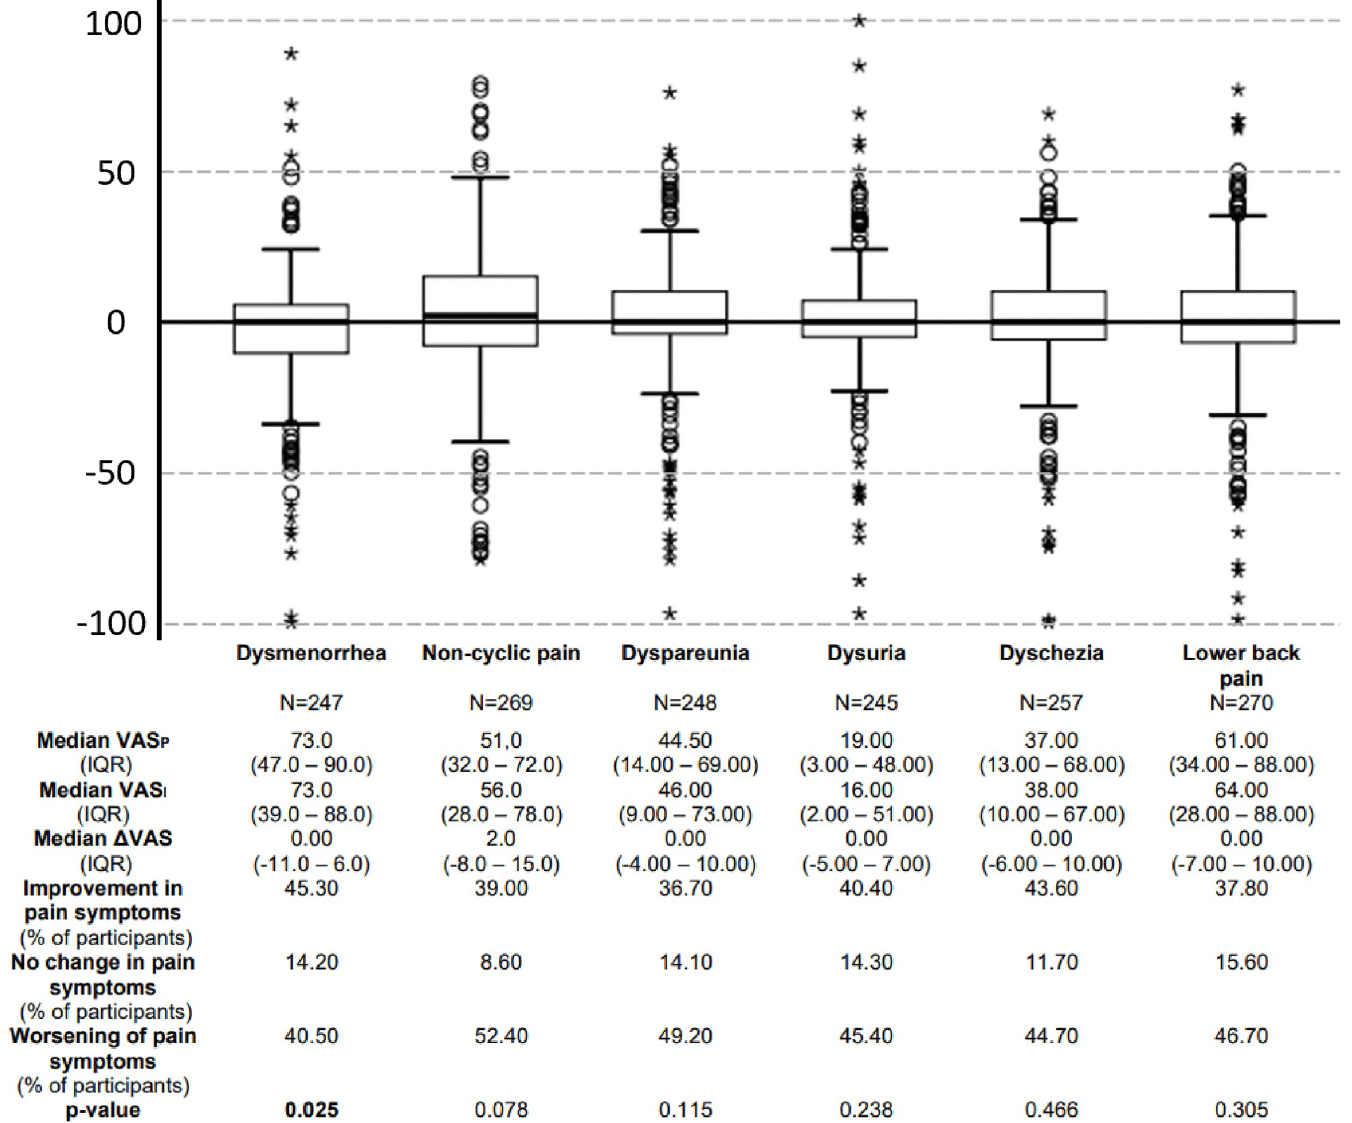
Fig 1. Differences of pain intensity ( Δ VAS) during social isolation or quarantine (VAS I ) and previous to social isolation or quarantine (VAS P ). Boxplots of the differences of pain intensity are displayed in all assessed pain modalities. Positive values mean increased pain during social isolation or quarantine. Negative values mean decreased pain during social isolation or quarantine. The value 0 means no changes in pain intensity. Data are presented as median values (IQR) and percentage of respondents who experienced decreased, increased or no change in pain intensity. N represents the number of women who answered the question about pain intensity regarding both time periods: Before and after social isolation or quarantine. Values in bold indicate statistical significance (Wilcoxon test), as the level of statistical significance was set to p � 0.05.